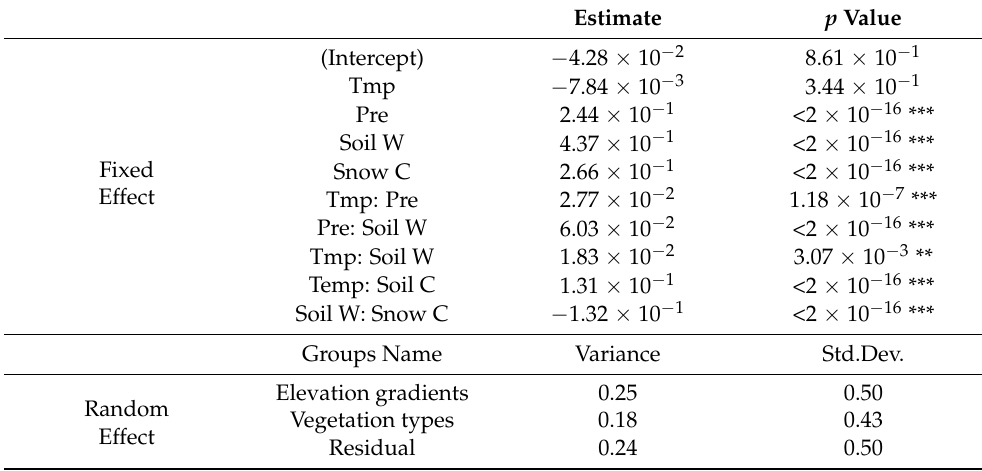
Table 1. Results of linear mixed-effects models of temperature (Tmp), precipitation (Pre), snow cover (Snow C), soil water (Soil W), and their interaction on